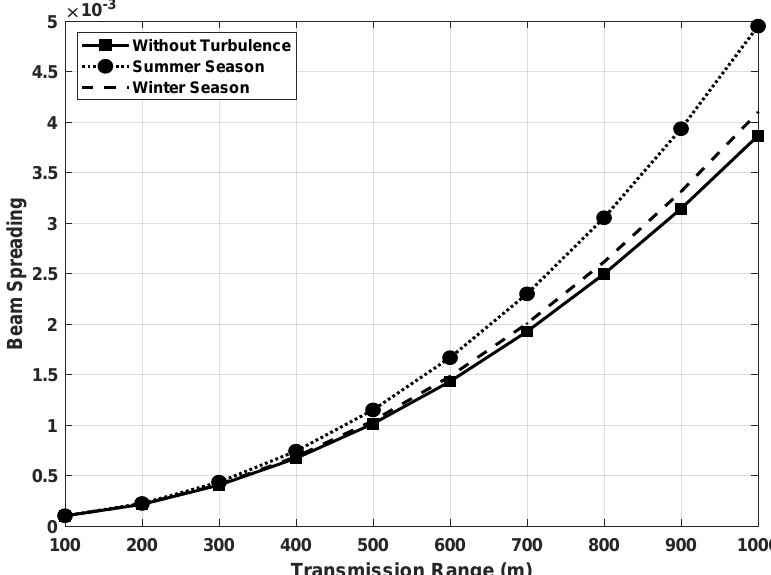
Figure 7. Comparison of the Beam Spreading for Different Transmission